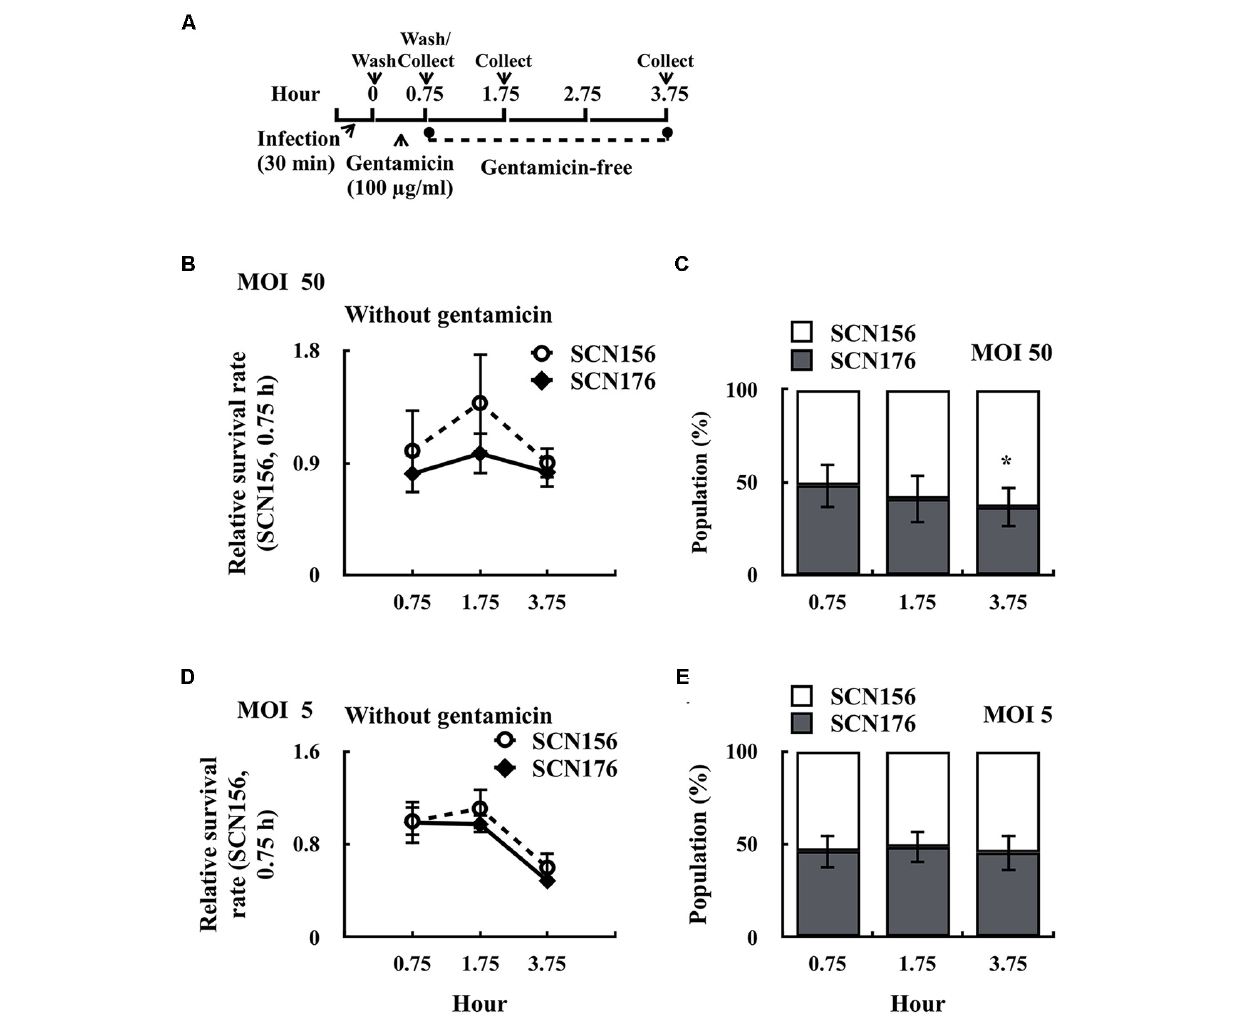
FIGURE 4 | Survival fitness of the capsule-deficient A20 (SCN156), AP3 (SCN157), and slo mutants of SCN157 (SCN176) on PMA-activated U937 cells. PMA-activated U937 cells were infected with mixed (1:1 ratio) SCN156 and SCN176 at multiplicity of infection (MOI) of 50 or 5 as shown in panel (A) . (B,D) Survival fitness of SCN156 (Cm R ) and SCN176 (Cm S ) at MOI of 50 or 5 in gentamicin-free incubation conditions. (C,E) The proportion of SCN156 and SCN176 in the recovered bacterial population at MOI of 50 or 5 in gentamicin-free incubation conditions. Error bars represent the standard deviations. ∗ p < 0.05.